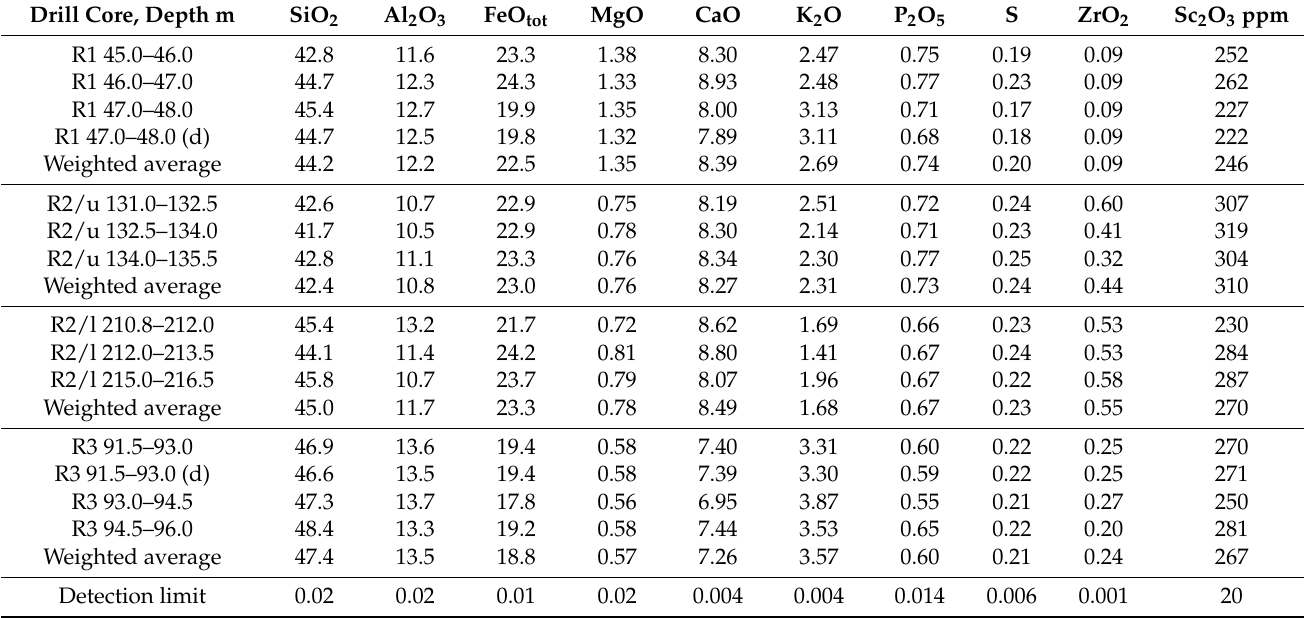
Table 2. Chemical data (Sc 2 O 3 in ppm, other oxides in wt%) for individual Kiviniemi drill core samples from R1, R2/u, R2/l and R3 as determined with ICP-OES. Calculated weighted averages for composite feed samples are shown. Duplicate (d) results for R1, 47.0–48.0 m and R3, 91.5–93.0 m, are also shown.